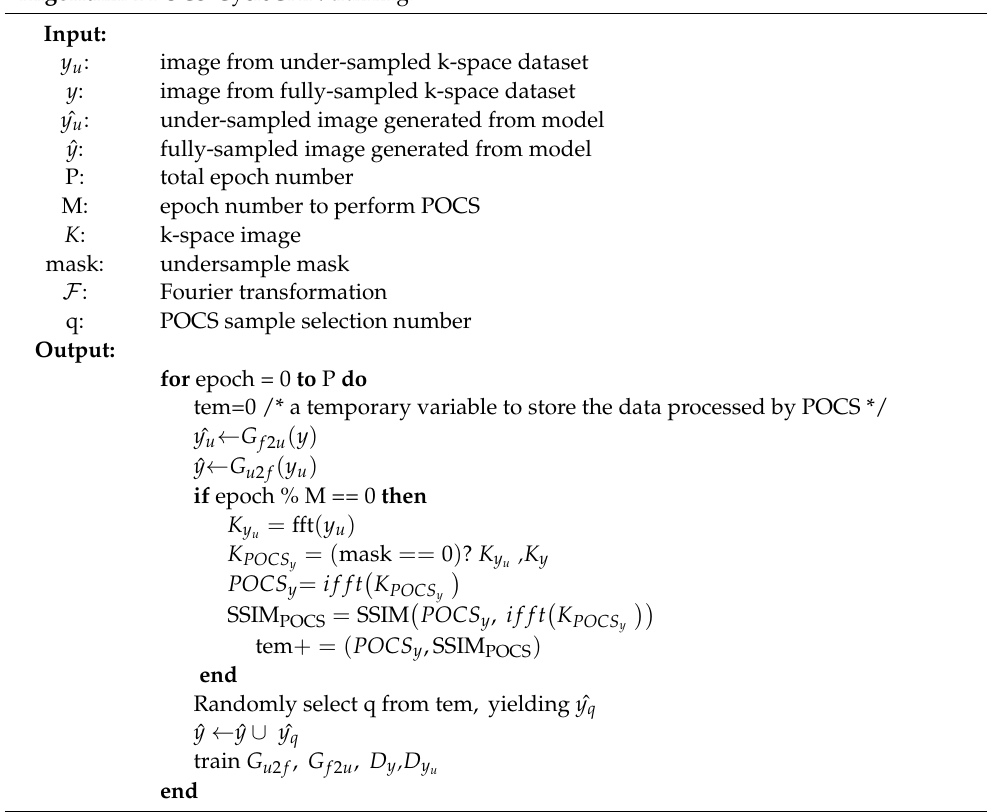
Algorithm 1 POCS-CycleGAN